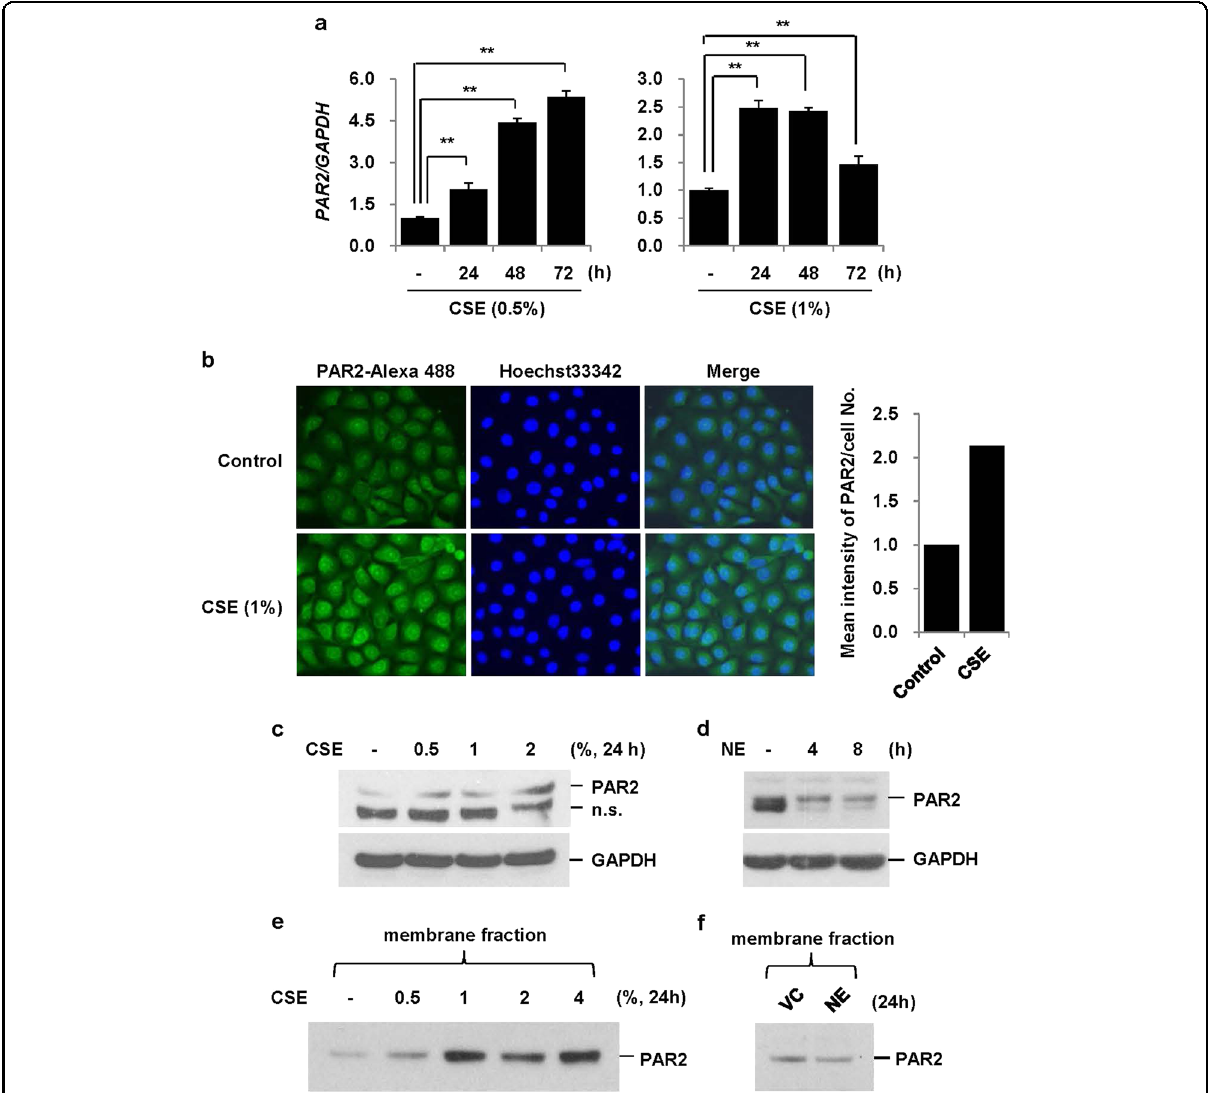
Fig. 3 CSE, but not NE, upregulates PAR2 expression. a BEAS-2B cells were treated with CSE (0.5 and 1%) for the indicated times. The expression of PAR2 was measured by quantitative real-time PCR. Data were normalized to the expression of GAPDH. Data represent the mean ± SD; ** P < 0.05. b Cells were stimulated with CSE (1%) for 24 h. The cells were fi xed and permeabilized for 10 min. Immuno fl uorescent staining of PAR2 was performed using an anti-PAR2 antibody, followed by an Alexa Fluor 488 antibody. Cells were analyzed using an ECLIPSE TE300 (Nikon) fl uorescence microscope. The mean intensity of PAR2 per cell number was determined using ImageJ. c , d BEAS-2B cells were treated with CSE (0.5, 1, and 2%) or NE (1 U/ml) for the indicated times. Total cell lysates were extracted and subjected to western blot analysis for PAR2 and GAPDH. e , f Cells were treated with CSE (0.5, 1, 2, and 4%) or NE (1 U/ml) for 24 h. The membrane fraction was isolated and then subjected to western blot analysis for PAR2 using an antibody to detect the N-terminal extracellular domain of PAR2. Results are representative of three independent